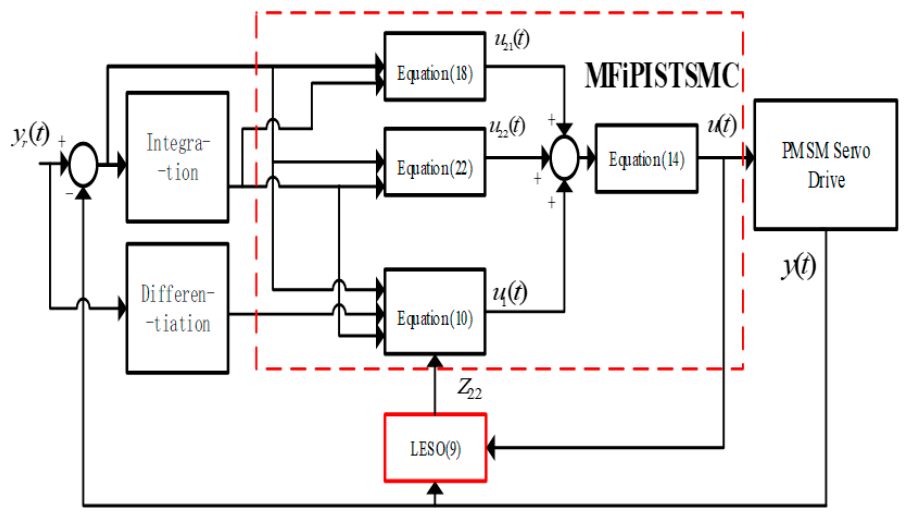
Figure 2. Structure diagram of the proposed MFiPISTSMC strategy.